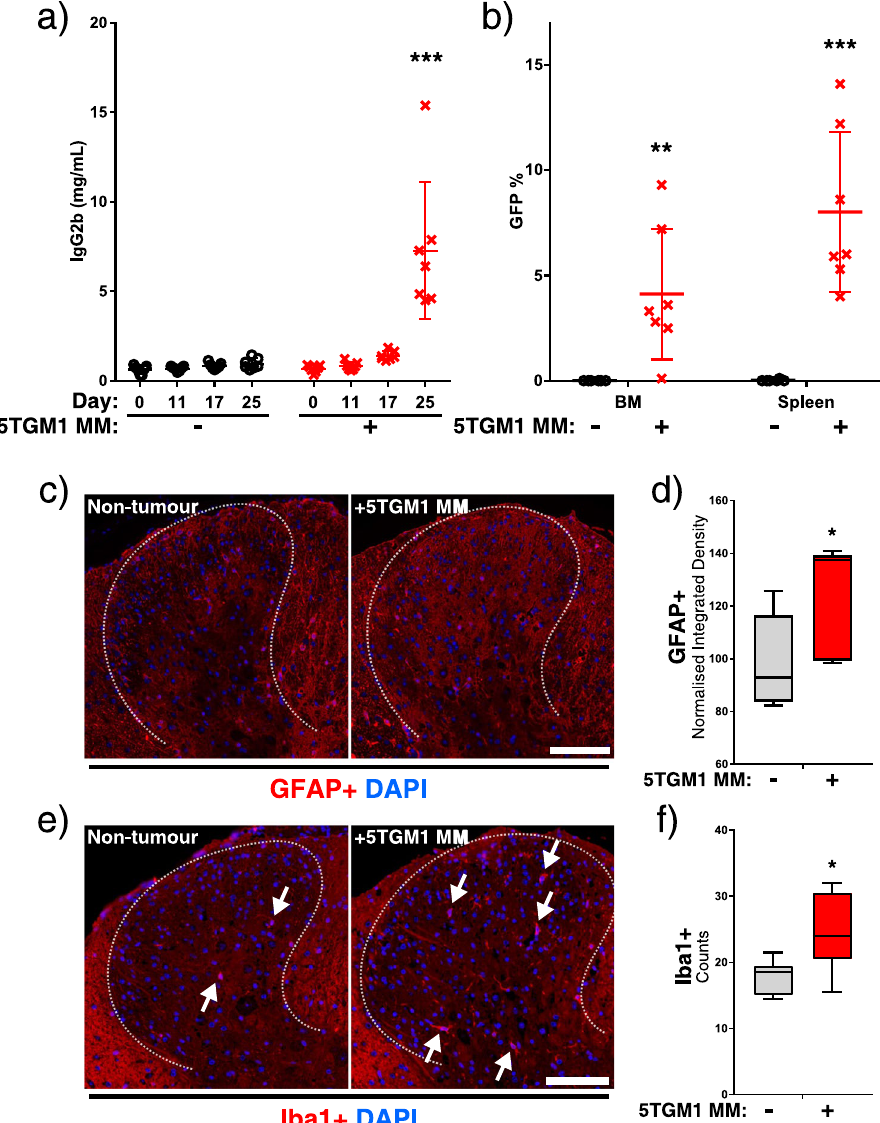
Figure 2. Development of myeloma with associated spinal glial cell activation. ( a ) Serum IgG2b levels were quantified by ELISA throughout the experiment. Statistical comparison by two-way ANOVA with Sidak’s multiple comparisons test. ( b ) Flow cytometry analysis of GFP + (5TGM1) population in bone marrow and spleens, displayed as percentage of total cell count. Statistical comparisons by t -test with Holm-Sidak multiple comparisons correction. ( c ) Representative images showing GFAP (red channel) staining in dorsal horn region (indicated by dashed line) of T8 spinal cords from non-tumour and 5TGM1 MM-bearing KaLwRij mice, with d ) normalised integrated density of GFAP staining. ( e ) Representative images of Iba1 staining (red channel) in the same region with Iba1 + cell bodies indicated with arrowheads, and ( f ) cell counts per dorsal horn for non-tumour and MM-bearing mice. All histology images counterstained with DAPI (blue channel), and white scale bars represent 100 µ m. Statistical comparisons in ( d ) and ( f ) by unpaired Student’s t -test. All statistical comparisons: ns : not significant, * p < 0.05; ** p < 0.01; *** p <